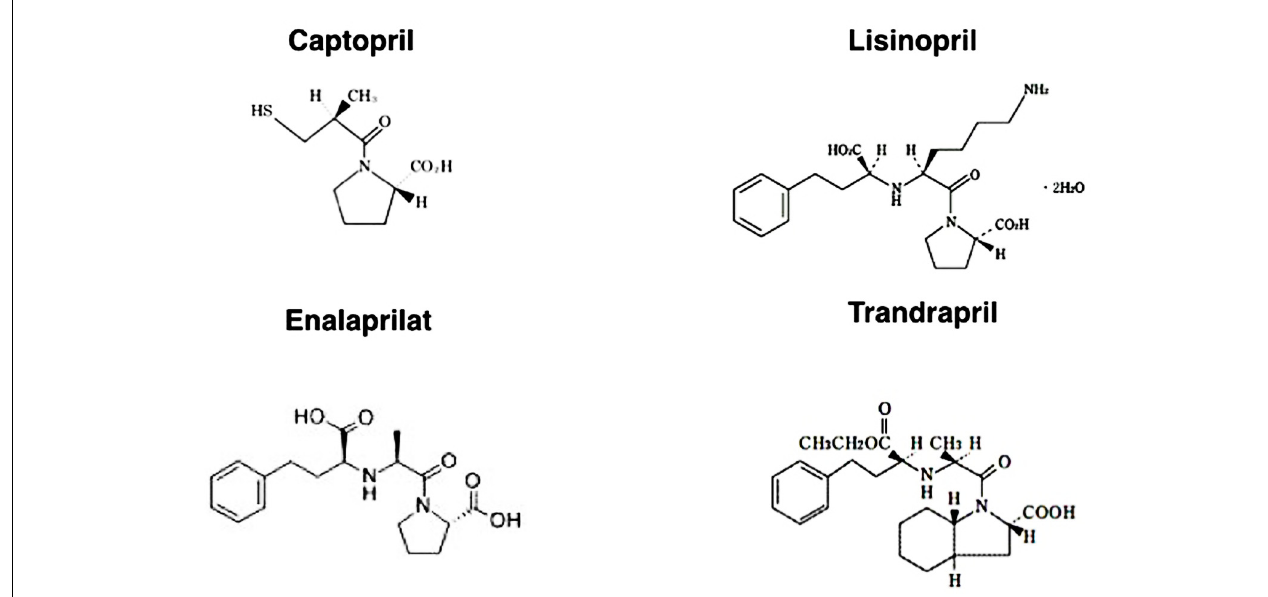
FIGURE 3 | Chemical structure ofACE